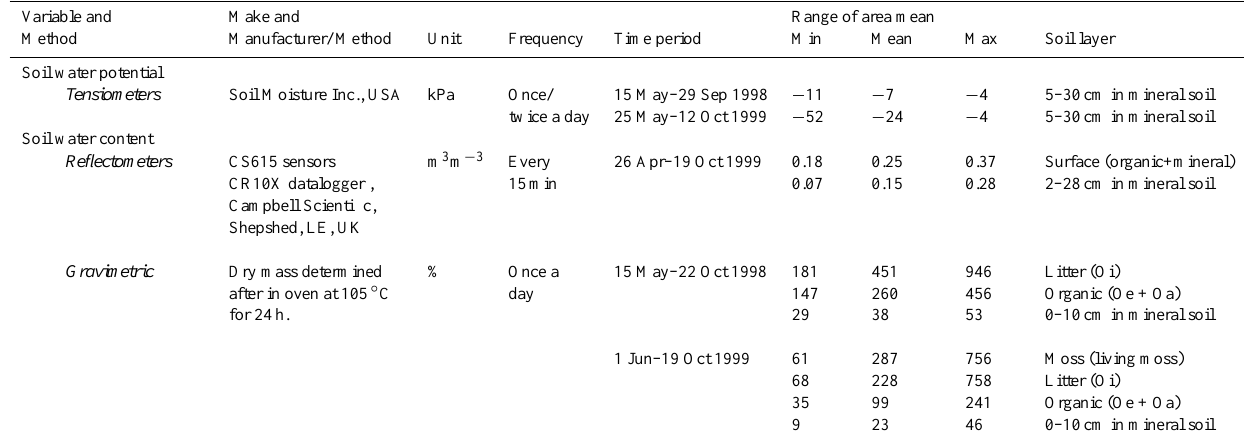
Table 1. Measurements of water potential and water content of soil on days when soil CO 2 efflux was measured. Variable and Make and